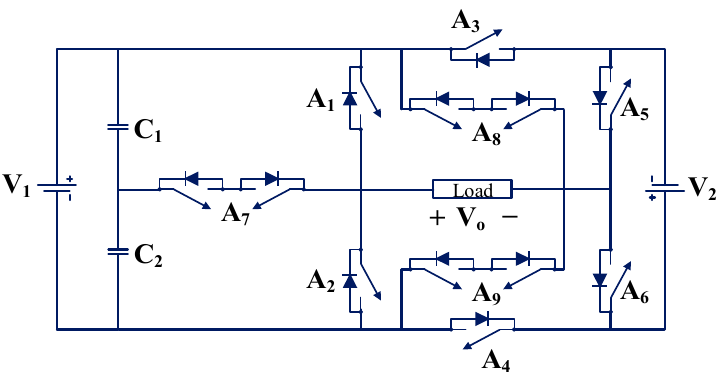
Figure 19. Single-phase nine-level FT MLI (TP20) [41].